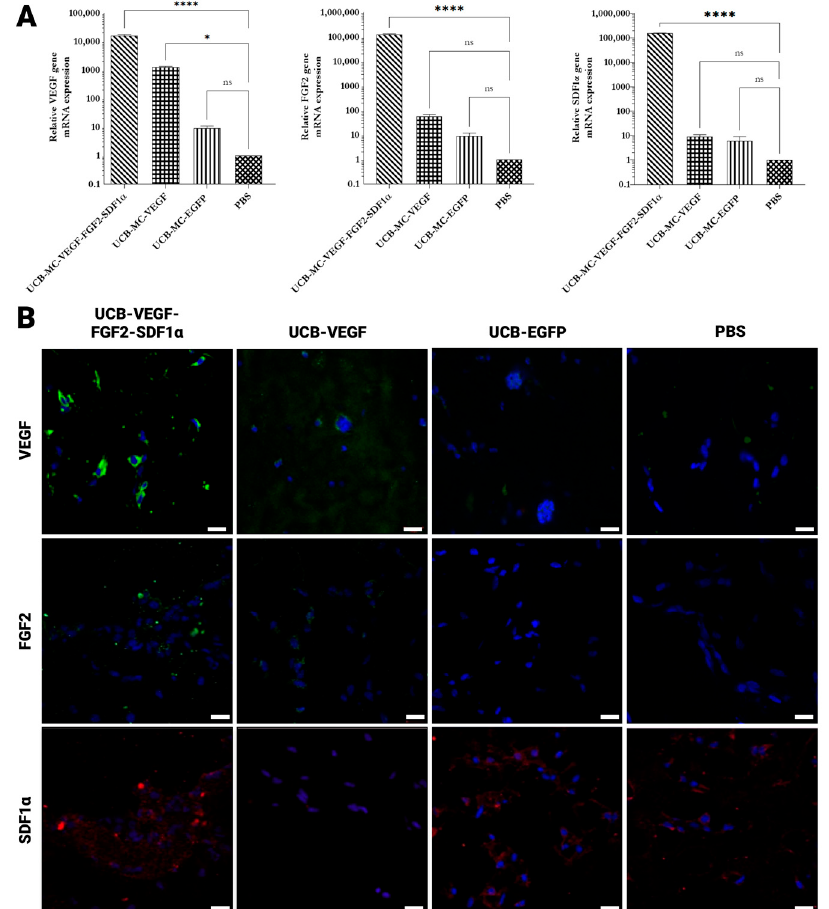
Figure 5. Analysis of transgenes expression in isolated Matrigel plugs one-week post-implantation. ( A ) Increasing concentrations of VEGF, FGF2, and SDF1 α mRNA levels in Matrigel plugs. RT-qPCR analysis was performed on the total RNA extracted from gelled Matrigel samples. ( B ) Immuno- histochemical analysis of Matrigel plugs. Staining for VEGF (green), FGF2 (green), and SDF1 α (red). Nuclei were counterstained using a DAPI solution (4 (cid:48) ,6-diamidino-2-phenylindole) (blue). Scale bars 50 µ m. UCB-MC-VEGF-FGF2-SDF1—umbilical cord blood mononuclear cells